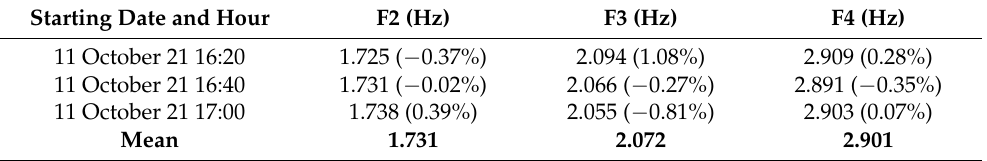
Table 5. Estimation of the natural frequencies in section 2 of the new bridge over one hour (GeoSIG). Starting Date and Hour